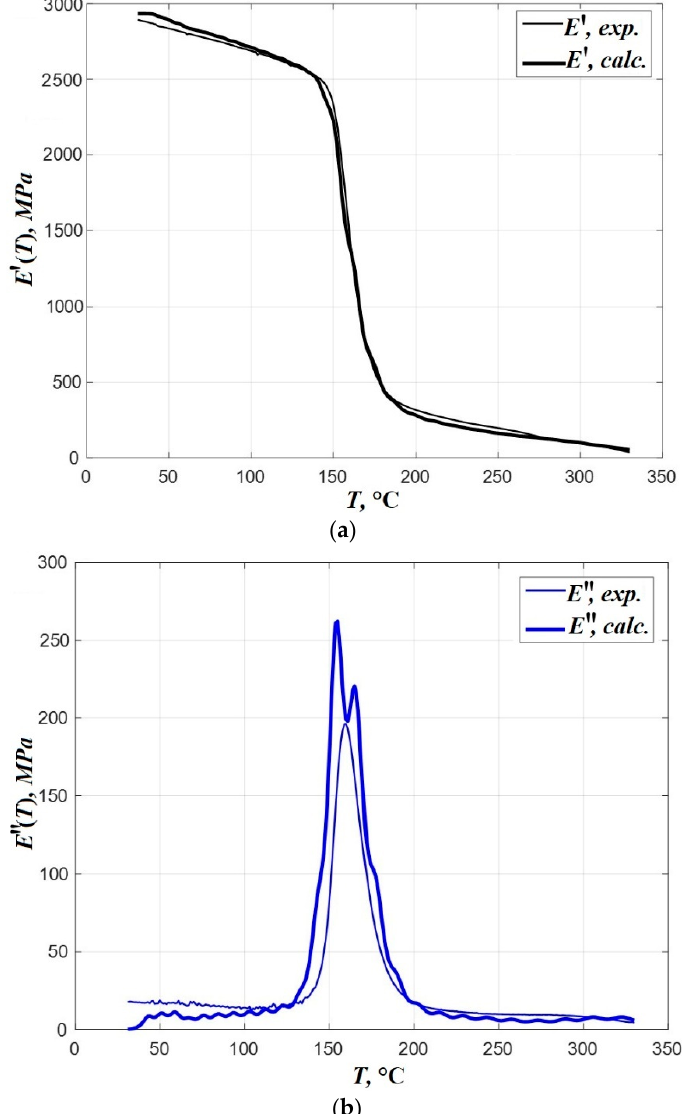
Figure 11. Temperature dependence: ( a ) the real part of the complex modulus 𝐸 ′ . The thin line is the experiment; the thick line is the calculation; ( b ) the imaginary part of complex modulus 𝐸 ′′ . The thin line shows the experiment, and the thick line shows the calculation.